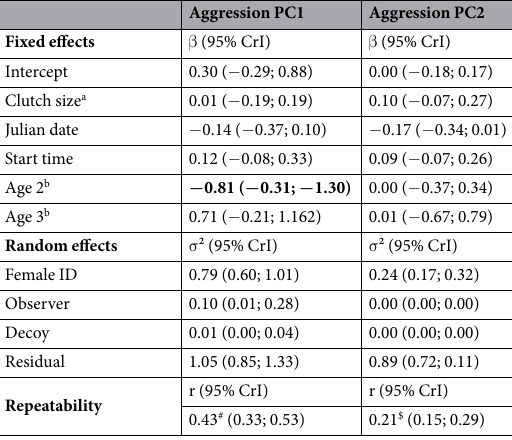
Table 2. Sources of variation in aggression principal components for female great tits (N = 98). Point estimates for fixed (β) and random (σ²) parameters, as well as adjusted repeatabilities (r), are given with 95% credible intervals (CrI). Fixed effects where CrI’s do not overlap zero are highlighted in bold. aNumber of eggs in the clutch at the moment of aggression testing. b Age class: ‘first-year’ (N = 41) is used as reference category, ‘Age 2’ is older (N = 50) and ‘Age 3’ is unknown age (N = 7). # Calculated based on minimum adequate model (MAM) including Age class as fixed effect and random intercepts for Female ID and Observer (R² GLMM(c) = 0.52). $ Calculated based on MAM including random intercepts for Female ID (R² = GLMM(c)